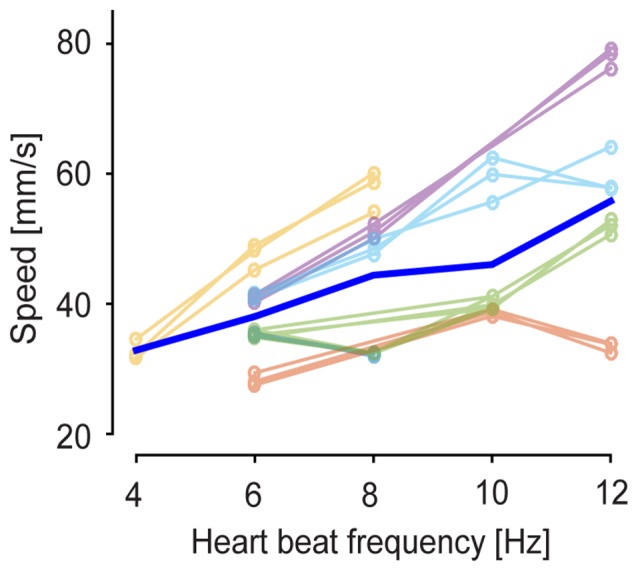
Wave propagation speed at different anesthetized states. Propagation speed on cortical surface was estimated at the single-event level (see “Materials and Methods” Section). Thin lines represent mean propagation speed of GWEs for each anesthetized state. Blue thick line indicates average across six experiments and three motifs.